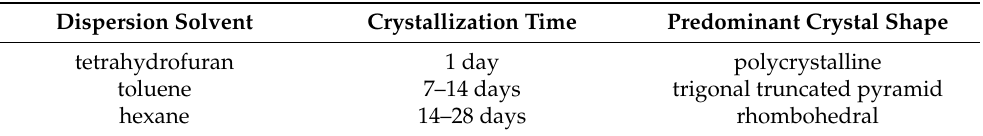
Table 1. Crystallization times for mesocrystals from platinum nanocubes in various dispersion solvents and their resulting predominant crystal